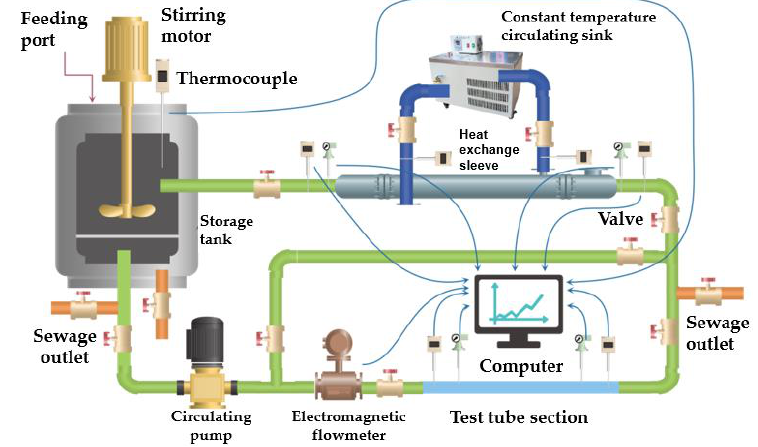
Figure 2. Schematic diagram of the experimental device.